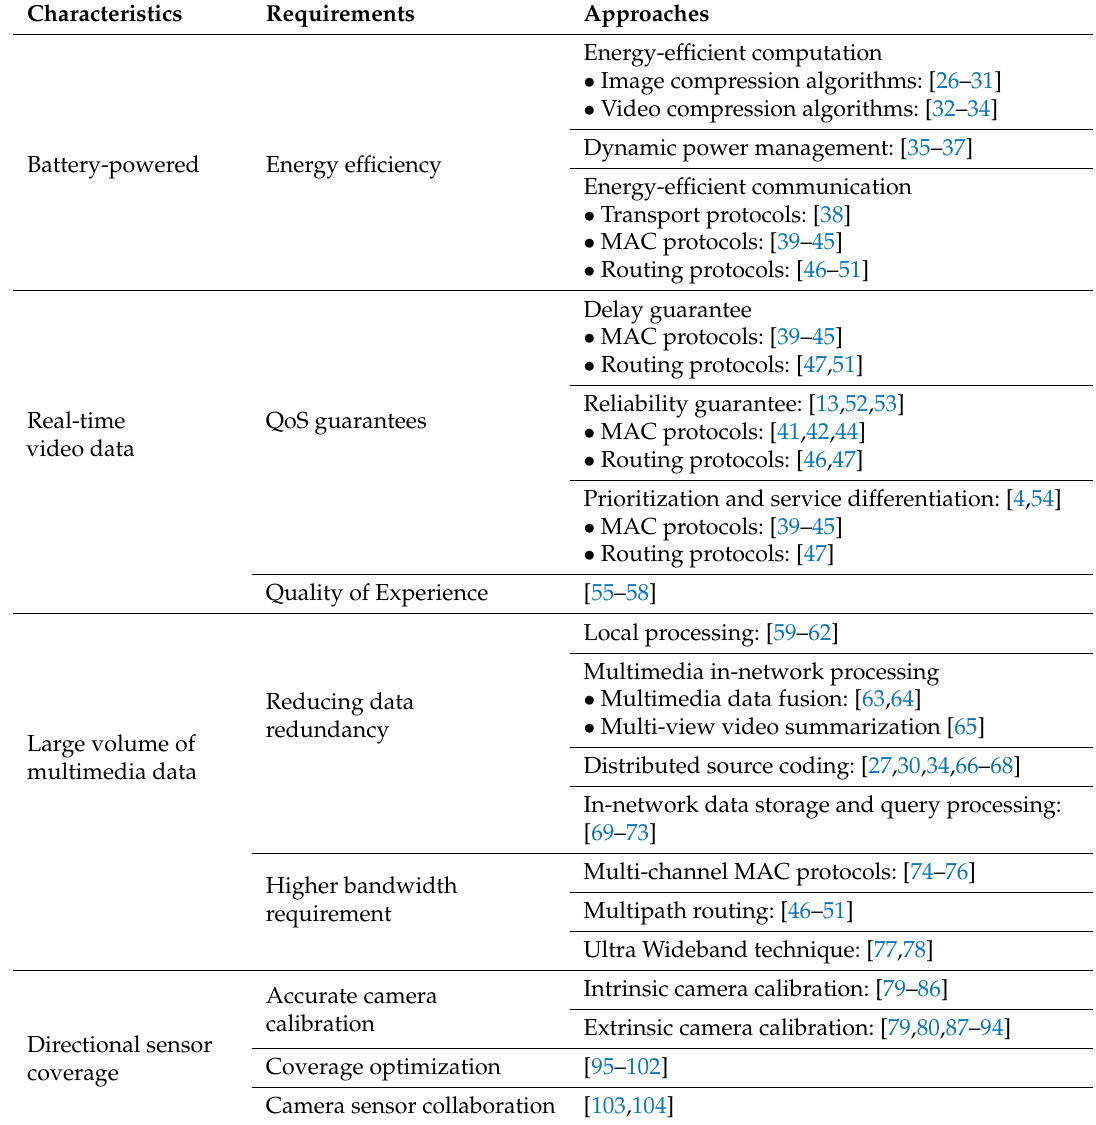
Table 1. Characteristics and Requirements of wireless multimedia sensor networks